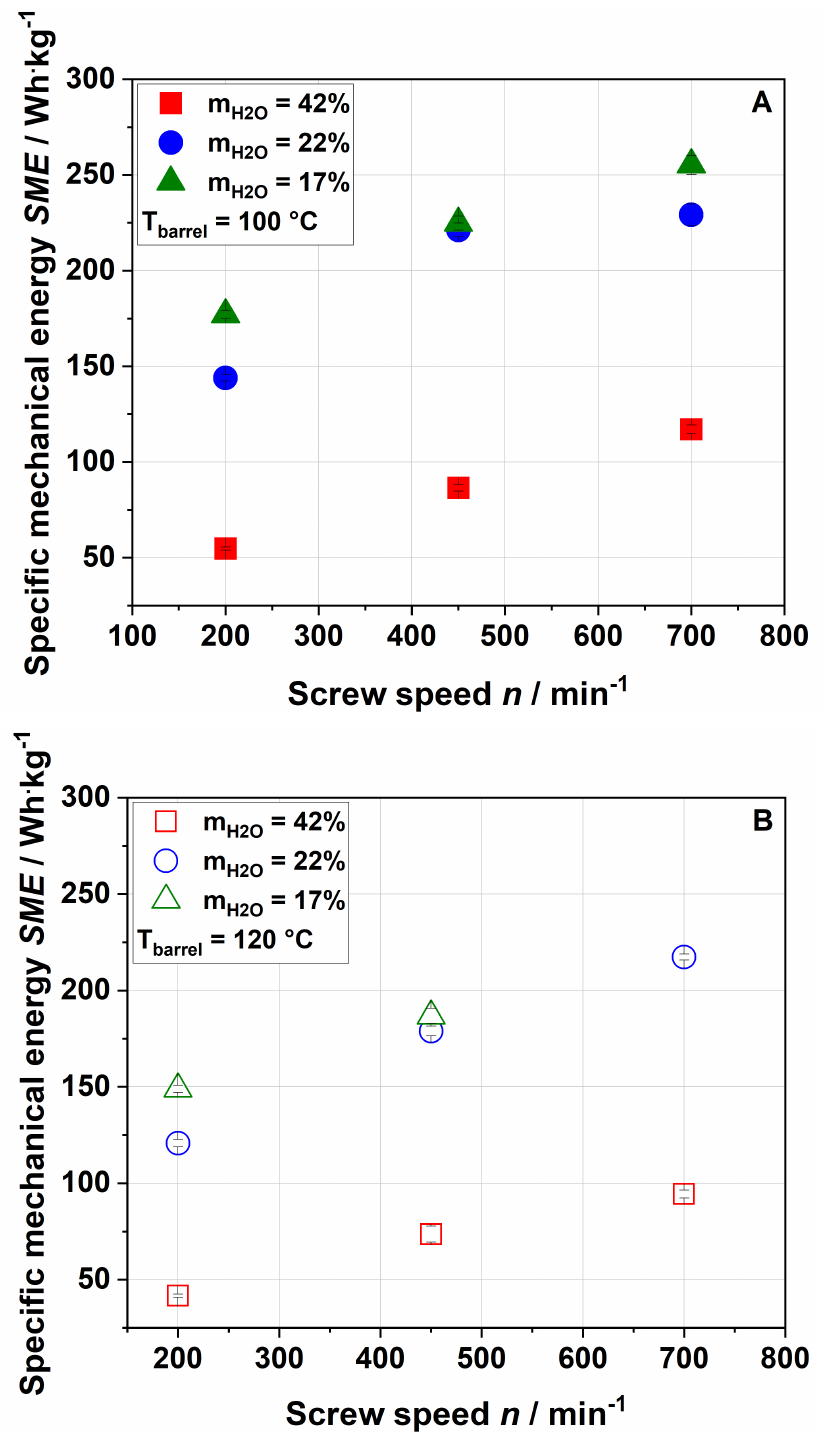
Figure 1. E ff ect of screw speed and water content on the specific mechanical energy (SME) at ( A ) 100 ◦ C barrel temperature and ( B ) 120 ◦ C barrel